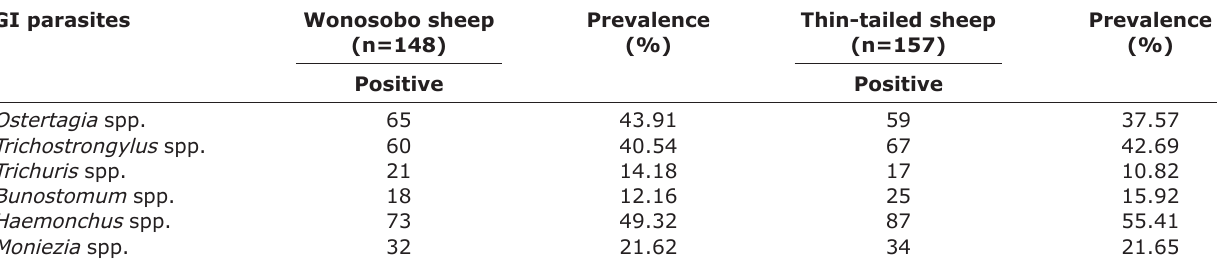
Prevalence Thin-tailed sheep Prevalence (n=148) (%) (n=157) (%) Positive Positive